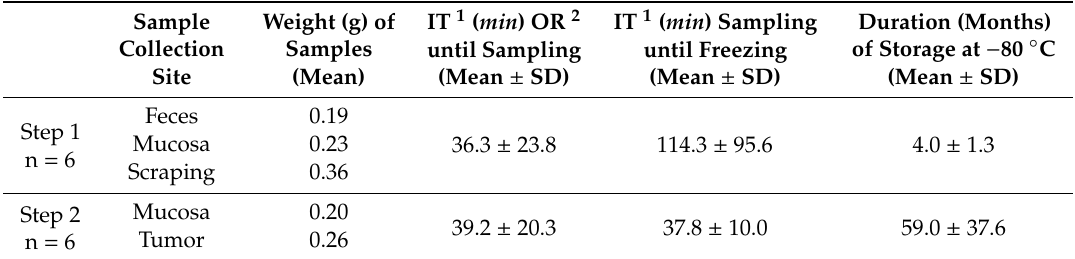
Table 1. Procedural characteristics of samples collected from di ff erent sample (Step 1 experiments) and tissue sites as well as storage duration (Step 2 experiments).